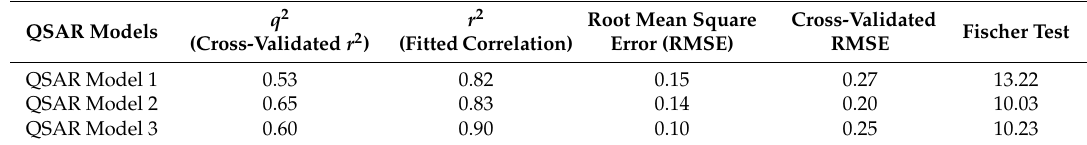
Table 4. Statistical parameters determined for the three QSAR models